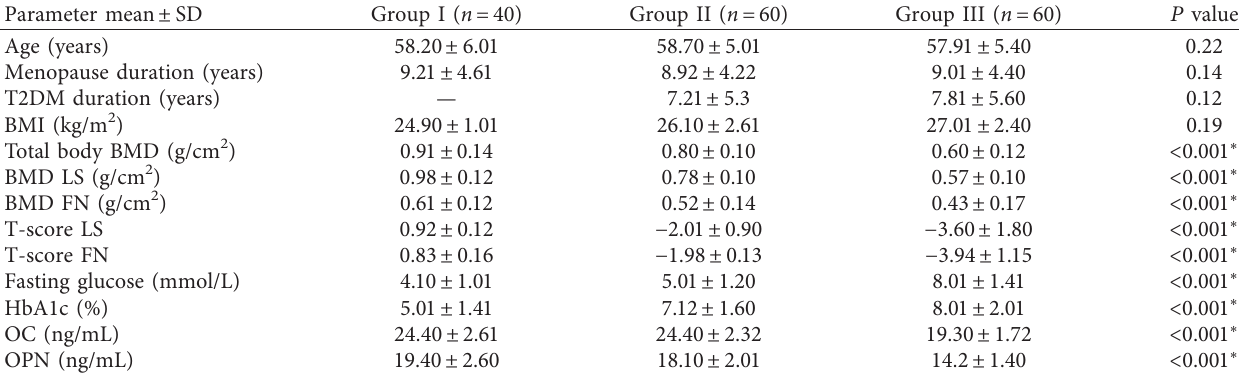
Table 1: Characteristics of postmenopausal women according to groups.